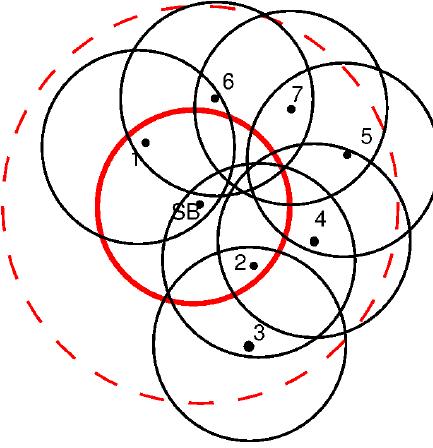
Figure 11. Case 2: deployment and transmission ranges.